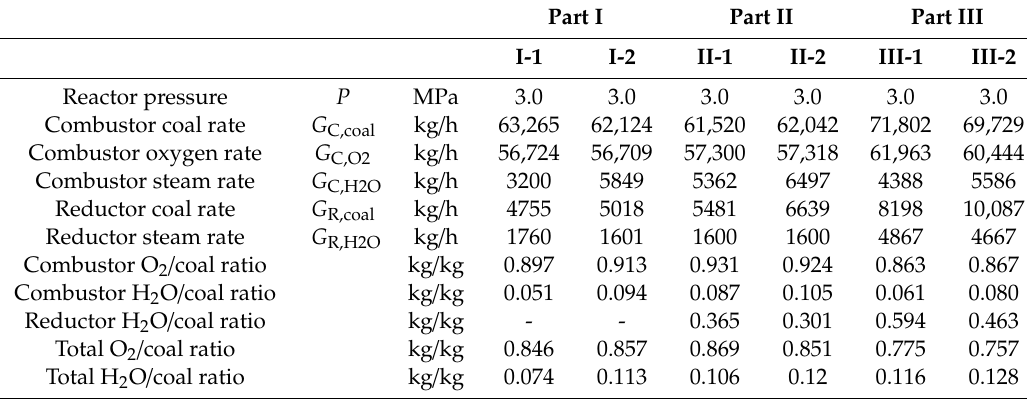
Table 3. The experimental conditions in the present study.